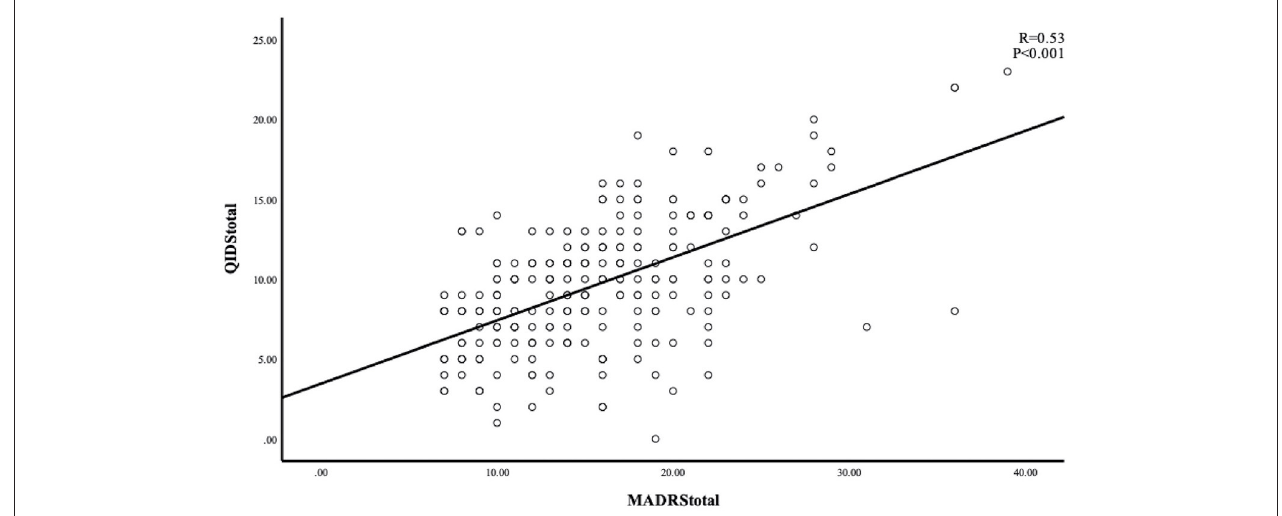
FIGURE 1 | Scree plot for the QIDS-SR at baseline.